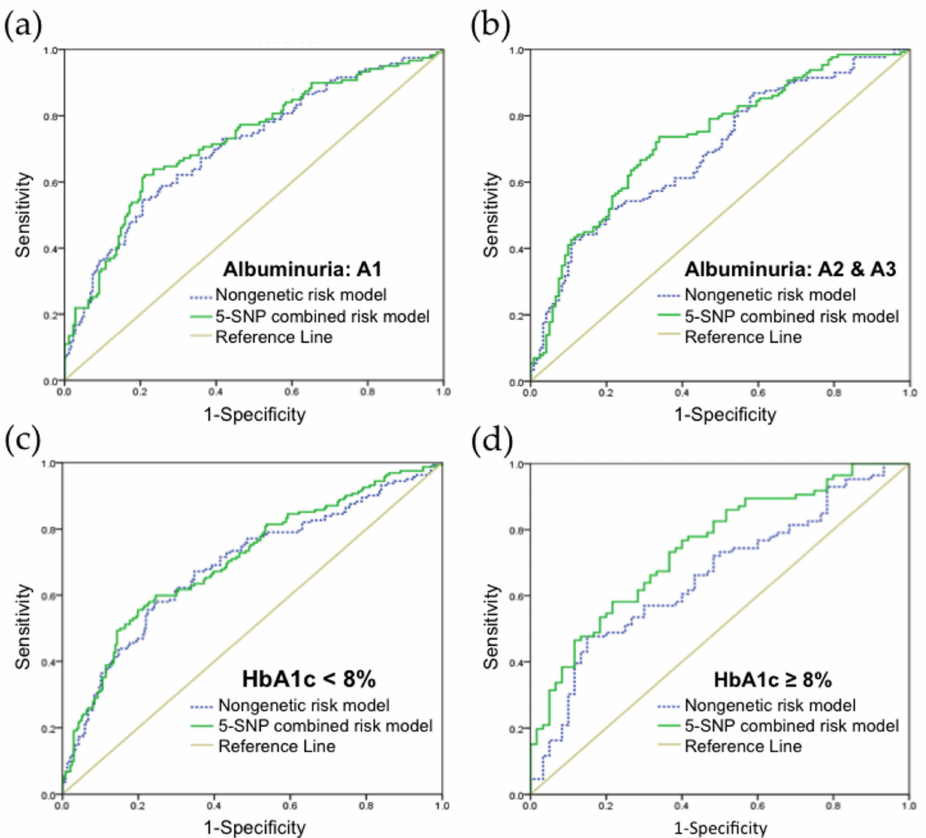
Figure 7. Receiver operating characteristic (ROC) curves and area under the curve (AUC) in different diabetic subgroups; ( a ) diabetic patients in albuminuria category A1. Blue line: nongenetic risk model (AUC = 0.708); green line: 5-SNP combined risk model (AUC = 0.724); ( b ) diabetic patients in albuminuria category A2 and A3. Blue line: nongenetic risk model (AUC = 0.693); green line: 5-SNP combined risk model (AUC = 0.731); ( c ) diabetic patients with HbA1c levels <8%. Blue line: nongenetic risk model (AUC = 0.690); green line: 5-SNP combined risk model (AUC = 0.707); ( d ) diabetic patients with HbA1c levels ≥ 8%. Blue line: nongenetic risk model (AUC = 0.659); green line: 5-SNP combined risk model (AUC = 0.746). The beige line represents the reference line (no